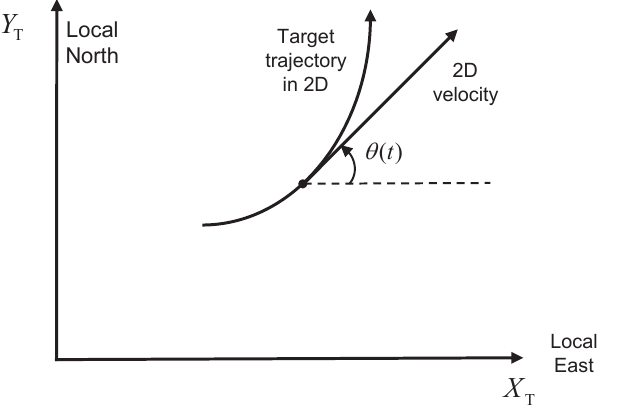
Figure 1. Definition of heading θ ( t ) in the tracker coordinate frame, θ ( t ) ∈ [ 0,2 π )